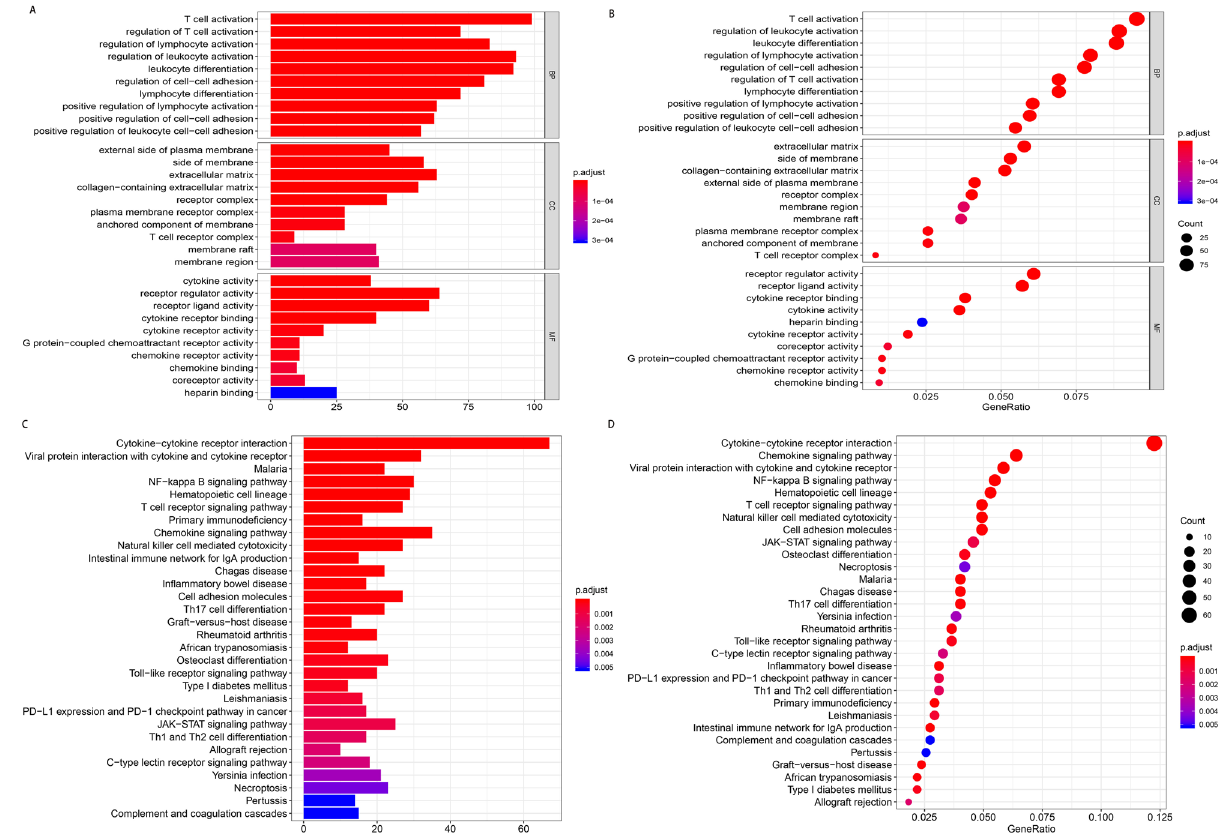
Figure 8. GO and KEGG enrichment analysis of immune-related genes. ( A , B ) The up-regulated DEGs were functionally enriched in GO. ( C , D ) The main pathways of the up-regulated DEGs were enriched in